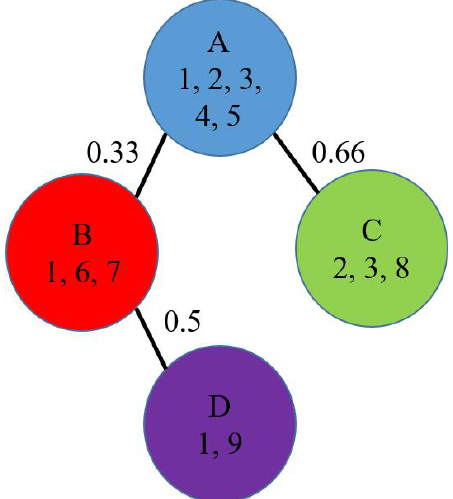
Figure 5. A tracklet association example during the execution of the CIR association. Suppose tracklet B has the max CIR with tracklet A. Since the size of tracklet B is smaller than the size of tracklet A, tracklet A is assigned as tracklet B’s parent. We repeat this process and group the tracklets as a